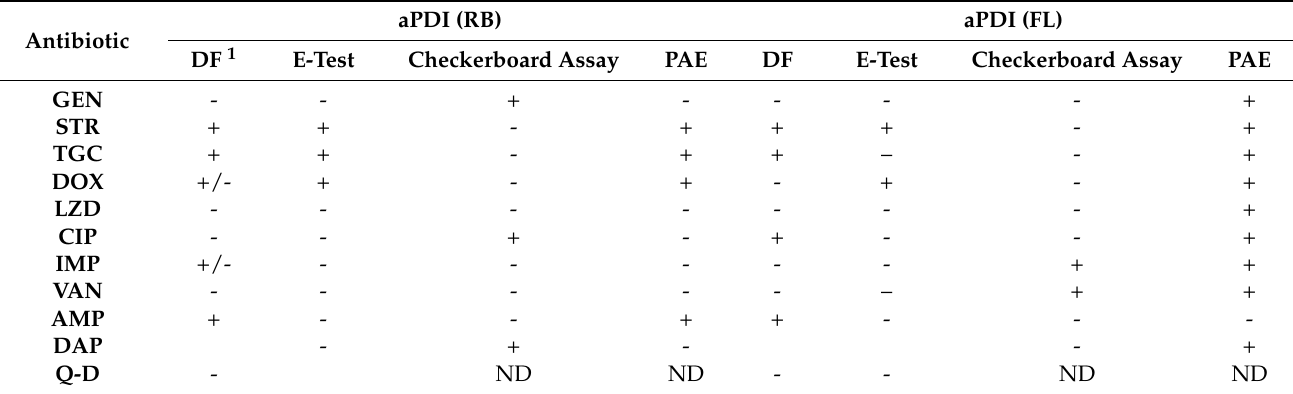
Table 5. Summarized results of synergy testing for E. faecalis .